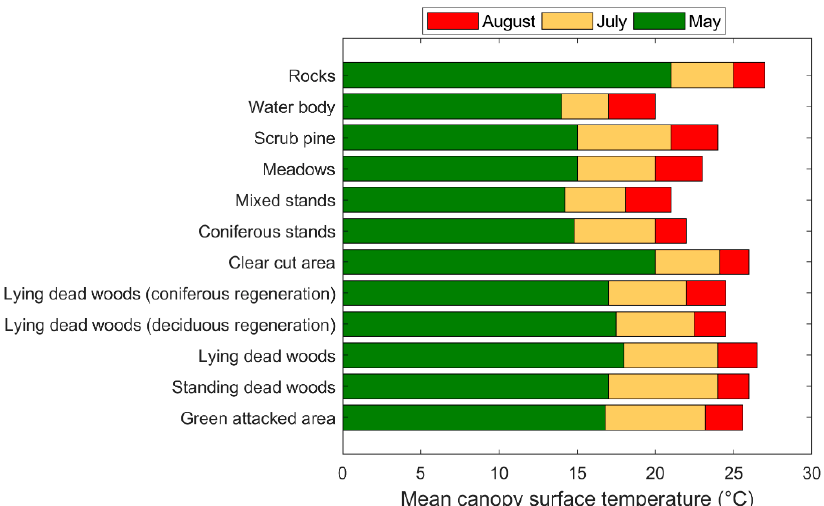
Figure 9. Mean canopy surface temperature over different habitat classes in the Bavarian Forest National Park, 2016. The graph shows that standing dead-wood, lying dead-wood, clear-cut, and rocky areas recorded high surface temperature comparing to other forest classes.